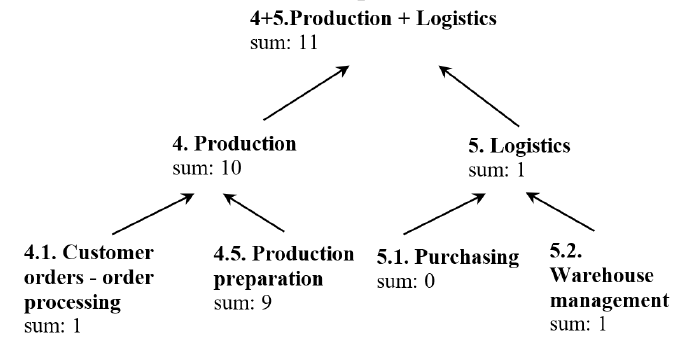
Figure 3. Results of multilevel warning